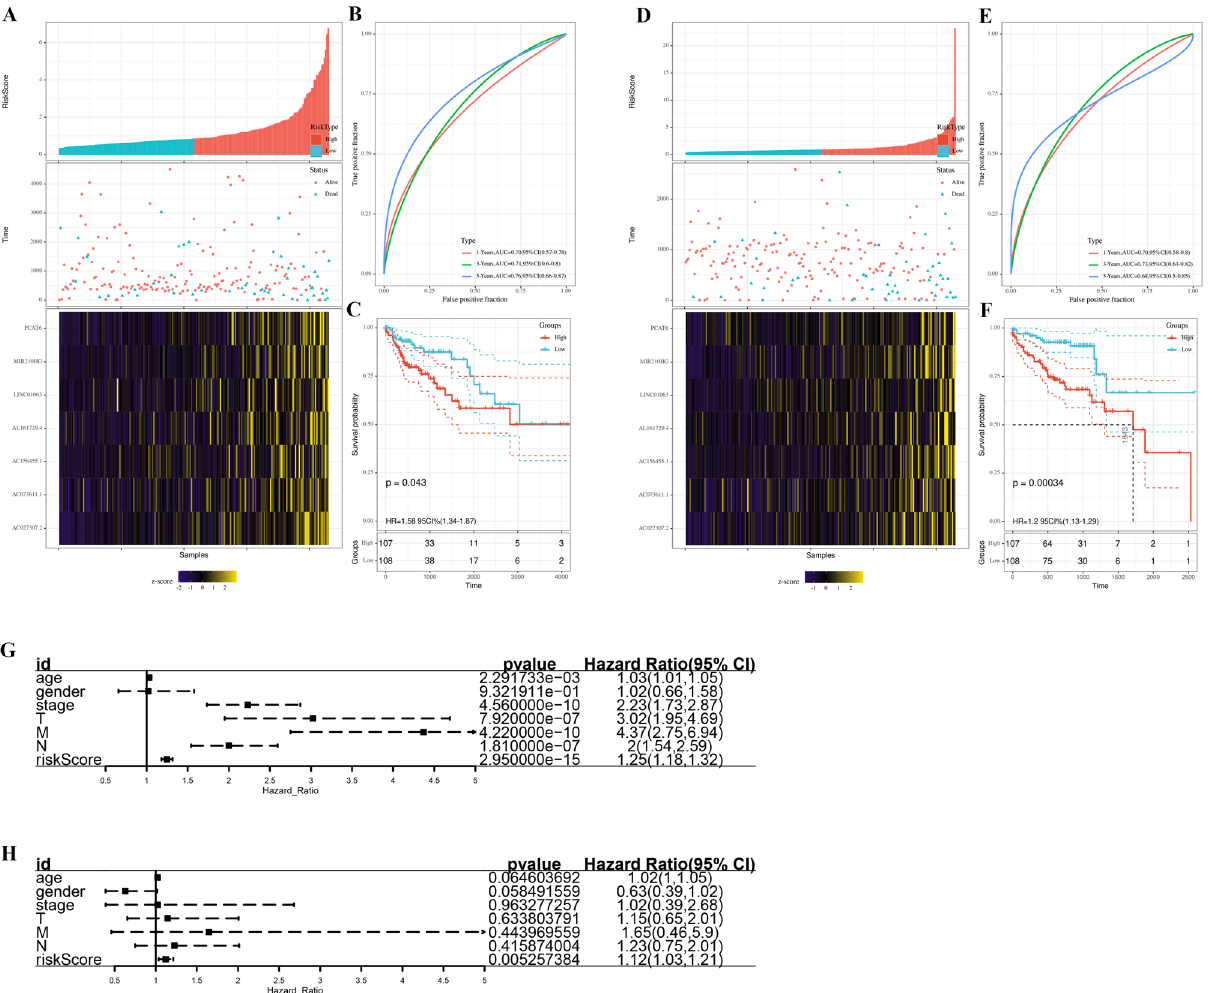
Figure 3. Construction and validation of the prognosis model. ( A ) The risk scores of patients in TCGA training cohort; ( B ) ROC curve of patients in TCGA training cohort; ( C ) Kaplan–Meier curve of patients in TCGA training cohort; ( D ) The risk scores of patients in TCGA validation cohort; ( E ) ROC curve of patients in TCGA validation cohort; ( F ) Kaplan–Meier curve of patients in TCGA validation cohort; ( G ) Univariate analysis of model and clinical features; ( H ) Multivariate analysis of model and clinical features. TCGA, The Cancer Genome